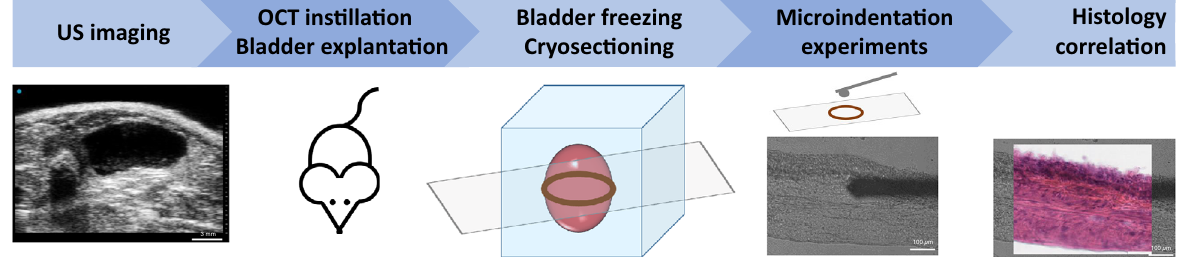
Fig. 6 Methodological approach for bladder stiffness characterization. Sample preparation protocol and pipeline of experiments. First, ultrasound (US) imaging is performed in order to determine the physiological OCT cryoprotectant bladder instillation volume. Animals are then sacri fi ced, the cryoprotectant is instilled into the bladder through a catheter and the bladder is then explanted and frozen. Cryosections are prepared and microindentation experiments are performed on the tissue slides both by AFM and nanoindenter. Afterwards, histology analysis was performed to con fi